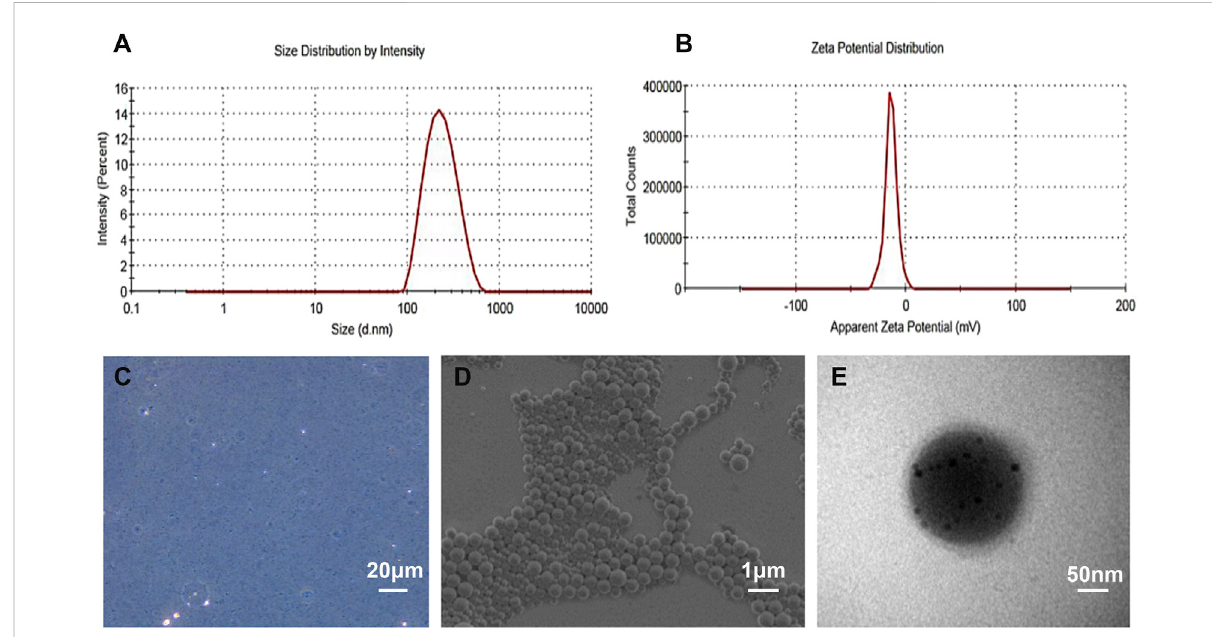
FIGURE 2 Characterization of the as-prepared NPs. (A) DLS size distribution of cRGD-PLGA-Fe 3 O 4 -PFOB NPs. (B) The zeta potential of cRGD-PLGA- Fe